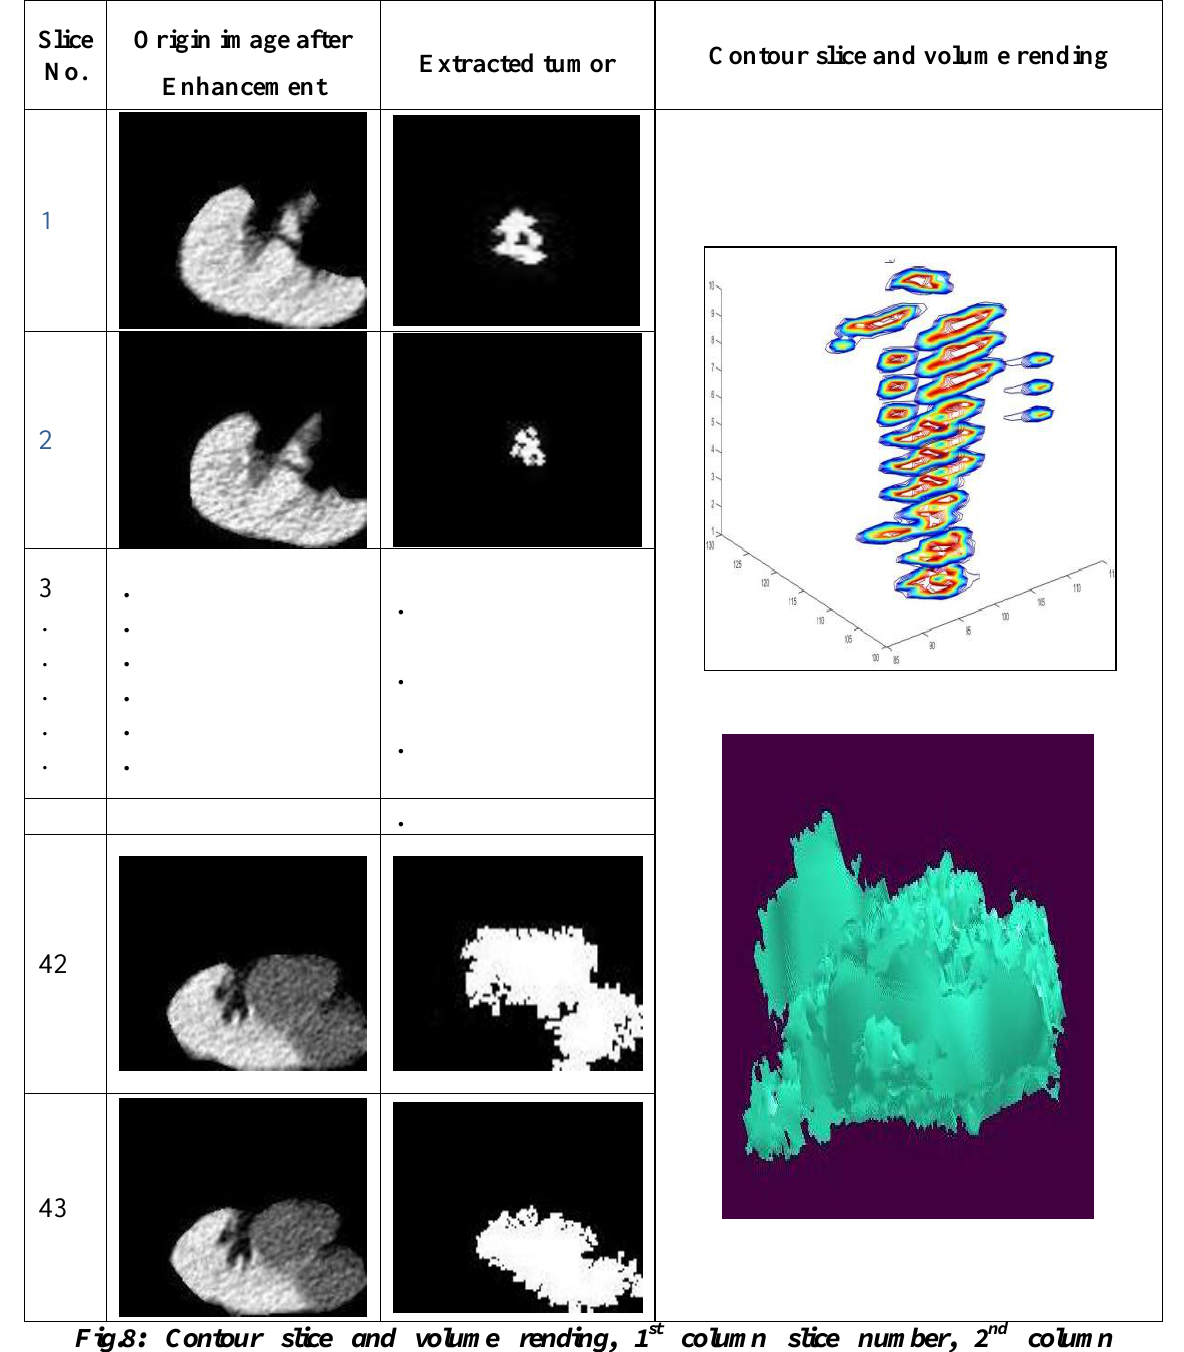
Fig.8: Contour slice and volume rending, 1 st column slice number, 2 nd column pre-processed image, 3 rd column tumor region extracted from pre-processed image, 4 th column contour slice and volume rendering of tumor